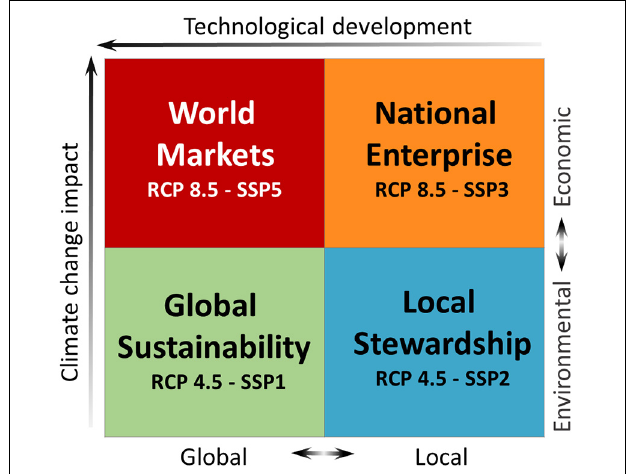
FIGURE 1 | Conceptualization of the four CERES scenarios in terms of impact and adaptation. Direction of the arrows indicates an increasing development/impact. Double arrows indicate diverging socio-political